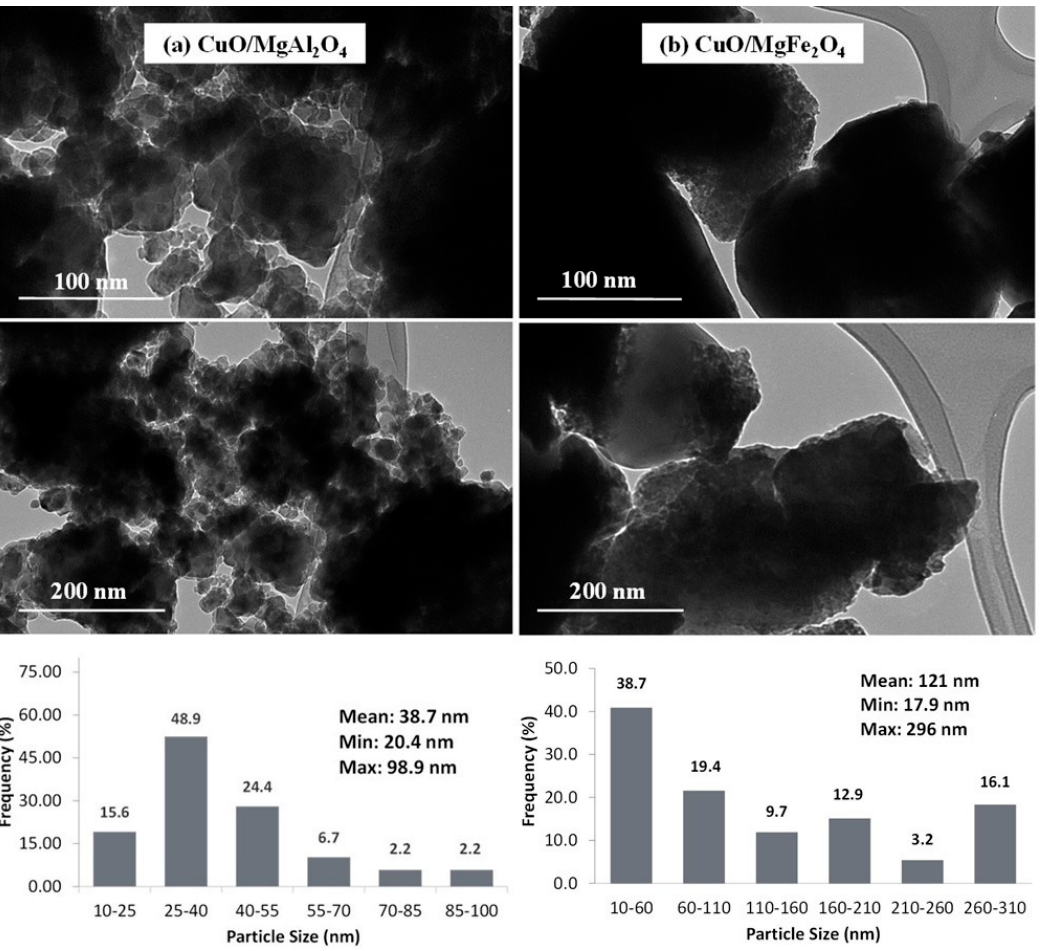
Figure 2. TEM images and size distribution of ( a ) CuO/MgAl 2 O 4 catalyst, ( b ) CuO/MgFe 2 O 4 catalyst.